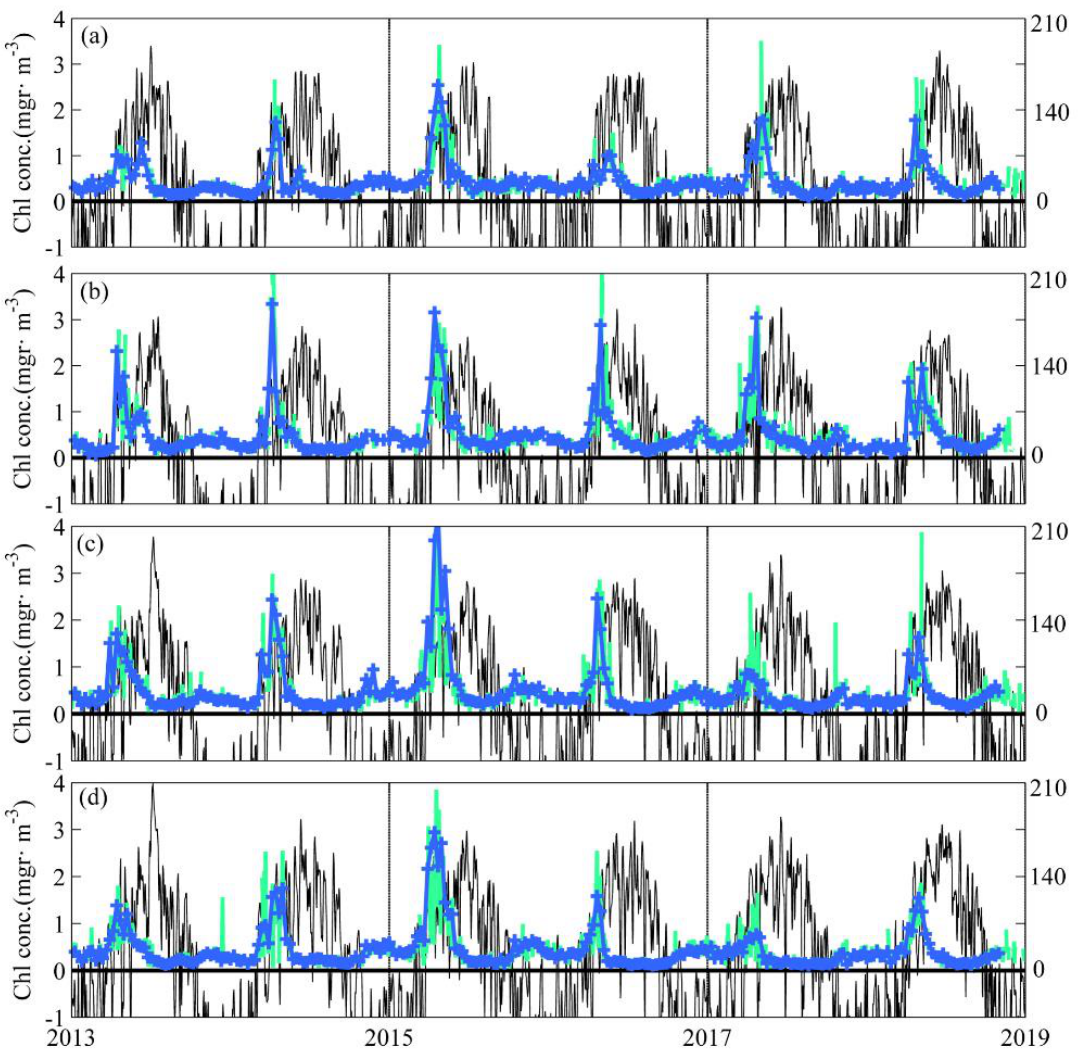
Figure 6. Surface chlorophyll concentration from daily (green line) and weekly (blue cross line) satellite-derived Chlorophyll a concentration from GlobColour project and net heat flux (Q 0 ) (black line) from the ocean to the atmosphere (negative values imply a heat loss by the ocean) at di ff erent locations in the mid-latitudes of the Eastern North Atlantic. ( a ) at the grid centered at 44.76 ◦ N, 15 ◦ W from NCEP / NCAR reanalysis data. Chlorophyll time-series are obtained as the average daily and weekly time-series within this grid 44.76 ◦ N ± 1.9 / 2 ◦ N and 15 ◦ W ± 1.9 / 2 ◦ E (NCEP / NCAR spatial resolution is 1.9 ◦ × 1.9 ◦ ). ( b – d ) idem at the grids at 46.67 ◦ N, 5.62 ◦ W; 44.76 ◦ N, 9.38 ◦ W; and 42.86 ◦ N, 11.25 ◦ W. Chlorophyll concentration scale is shown in the left y-axis in mgr · m − 3 and Q 0 in the right y-axis in W · m − 2